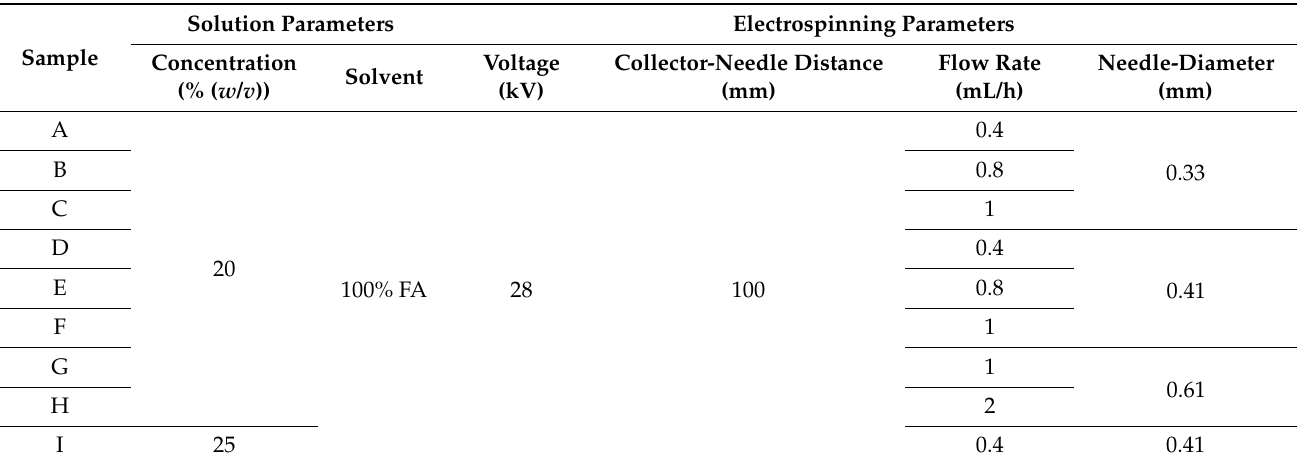
Table 2. Operational conditions tested during electrospinning